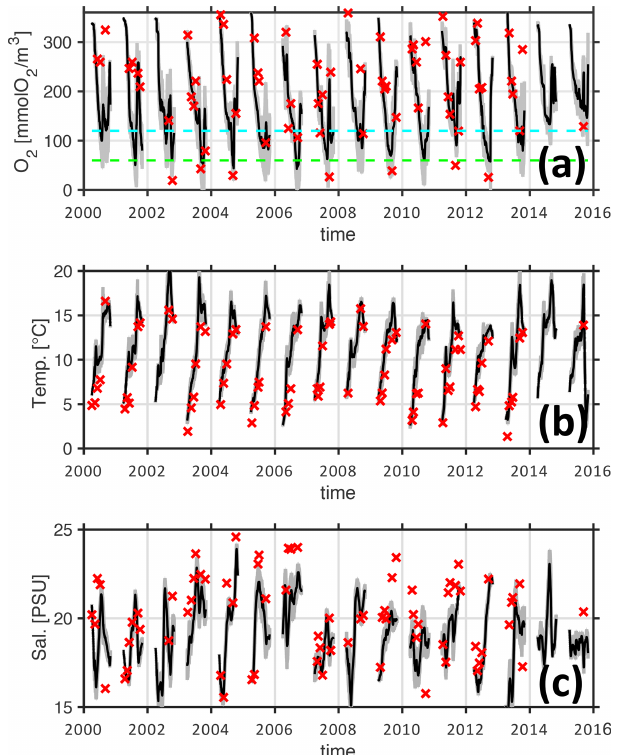
Figure 5. Simulated and observed oxygen concentrations at the bot- tom (20m depth) of the monitoring station Buoy 2a . Panels (a–c) refer to oxygen concentrations, temperature, and salinity, respec- tively. Red crosses denote observations. The black line denotes the ensemble mean of the simulations MedMix and LoMix . The gray line envelopes the ensembles’ extremes at any given time. The hor- izontal dashed cyan and green lines in panel (a) show 120 and 60mmolO 2 m − 3 hypoxia thresholds, respectively.